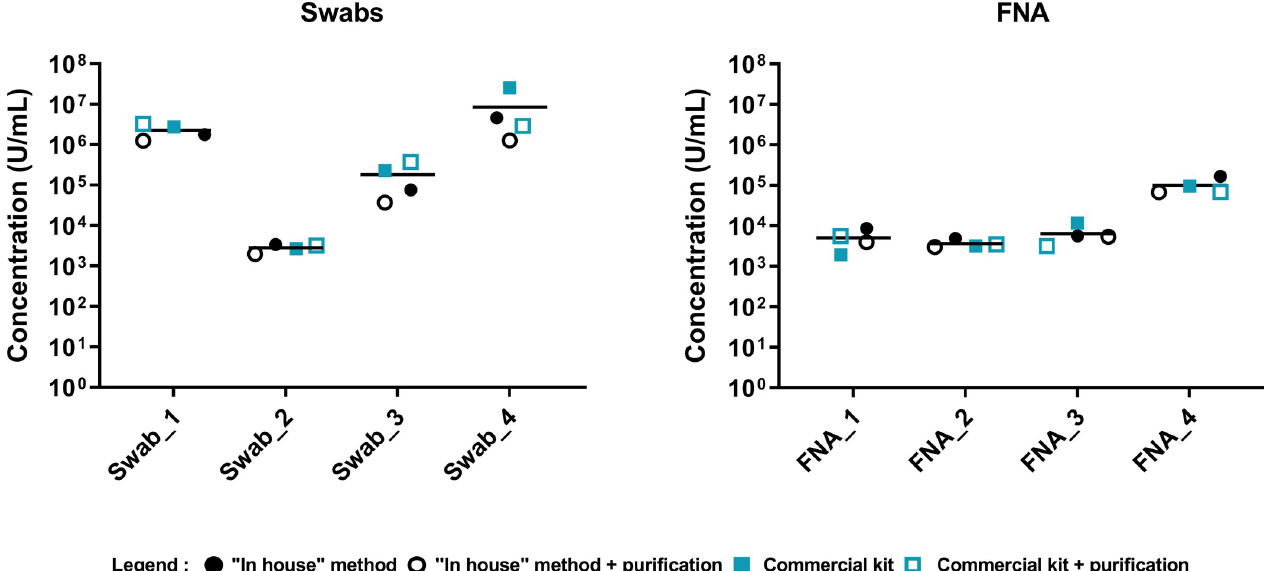
Fig 2. Comparison results of DNA extraction methods. (A) from four swabs, and (B) from four FNA. No significant difference was observed between the “in-house” method and the commercial kit (Dunn’s multiple comparisons test).